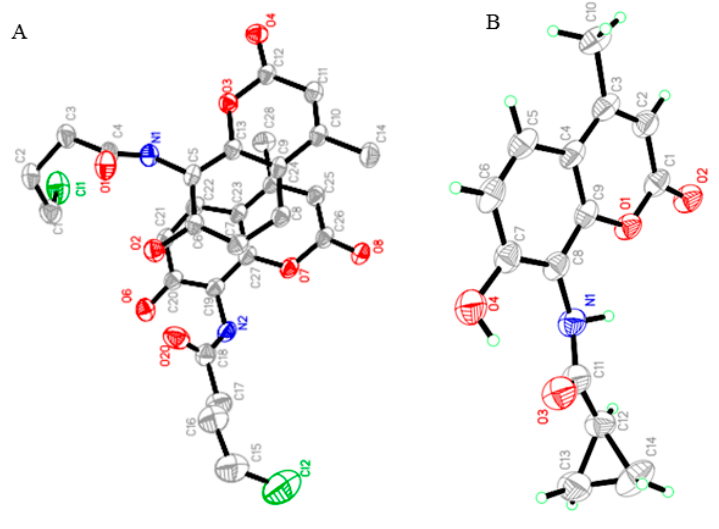
Figure 1. X-ray crystal structure of compounds 4bd ( A ) and 4be ( B ). Table 1. Acaricidal activities of title compounds against T. cinnabarinus (%, 72 h corrected mortality). Compd.